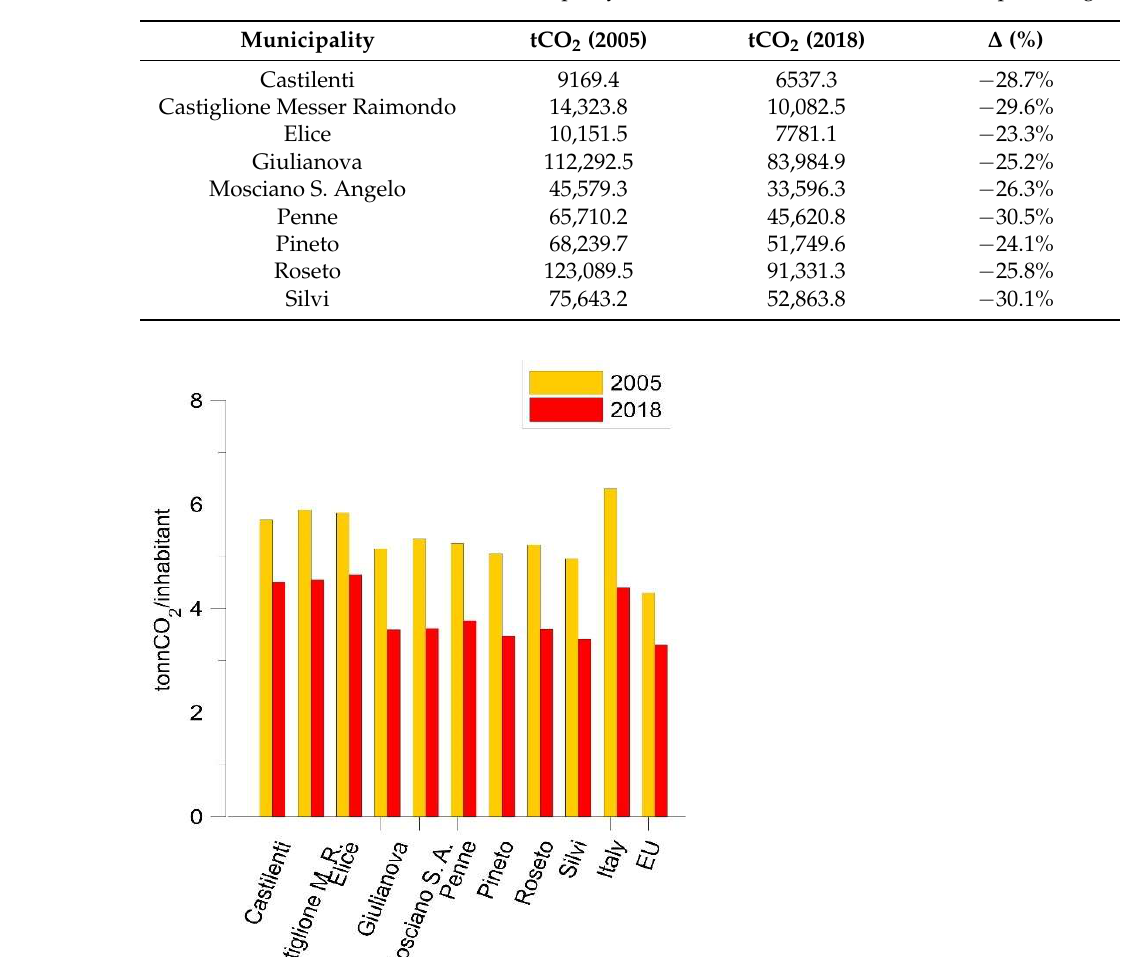
Table 7. Overall emissions for each municipality considered (tCO 2 ) and reduction as a percentage.